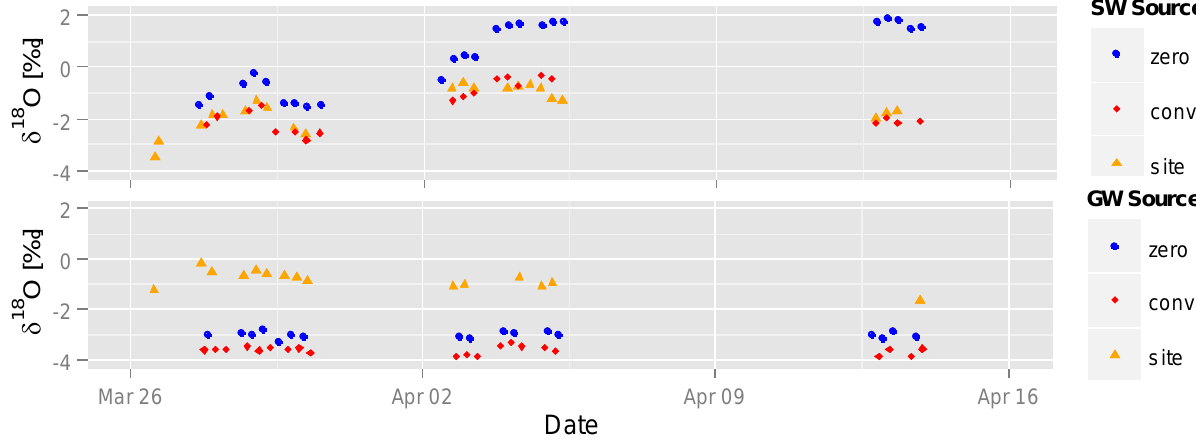
Figure 7. δ 18 O isotopic composition of SW ( top ) and GW ( bottom ) from different fertilized rice plots (zero, conventional and site-specific) between the end of March and mid-April 2012. Gaps in the graph are given due to setup changes and system testing. Note that only the instrument’s internal calibration was